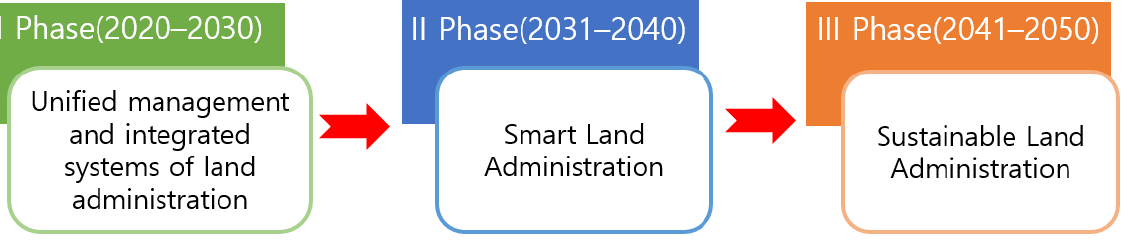
Figure 1. Land administratio n development perspective of Mongolia based on “Vision 2050.”